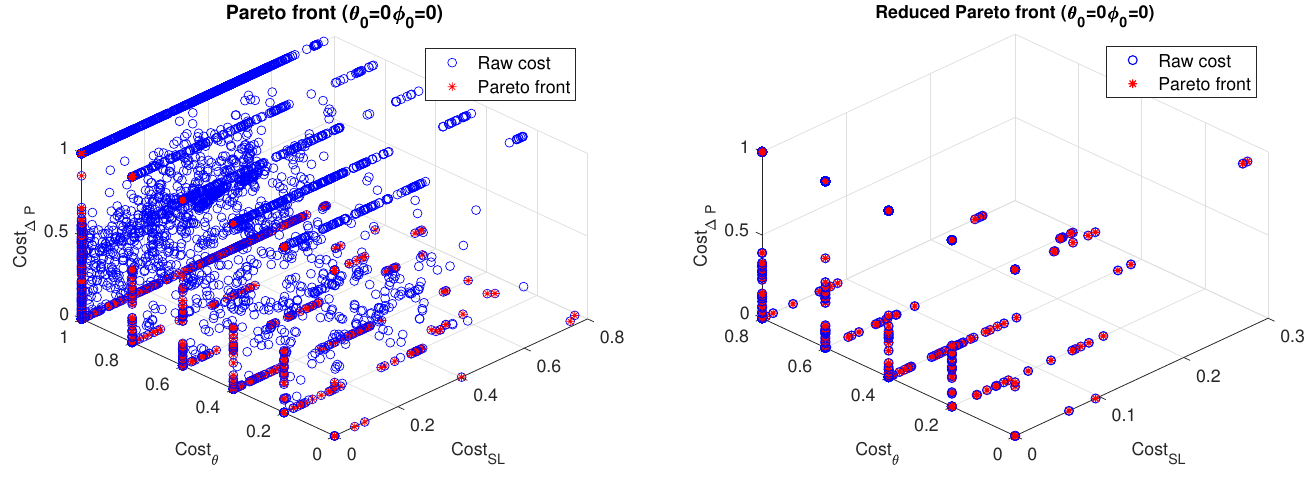
Figure 14. Optimization